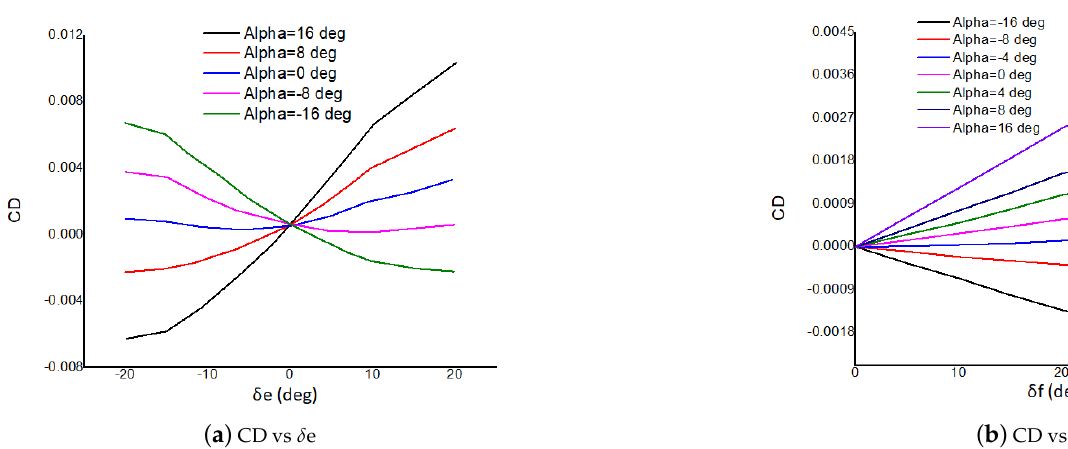
Figure 6. Analysis of longitudinal aerodynamic coefficients with deflection of the control surfaces ( a ) Variation of drag coefficient with elevator deflection; the figure shows the variation of the drag coefficient at each deflection angle from the positive side to the negative side. ( b ) Variation of drag coefficient with flap deflection; the figure shows the variation of the drag coefficient due to single slotted flap deflection.